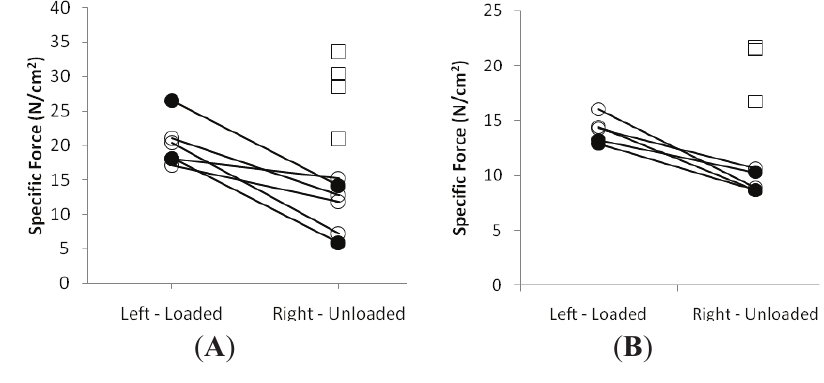
Figure 3. Average single muscle fiber specific force in the soleus ( A ) and the EDL ( B ) in the loaded and unloaded limbs in the control (squares), LC (open circles) and EC groups (filled